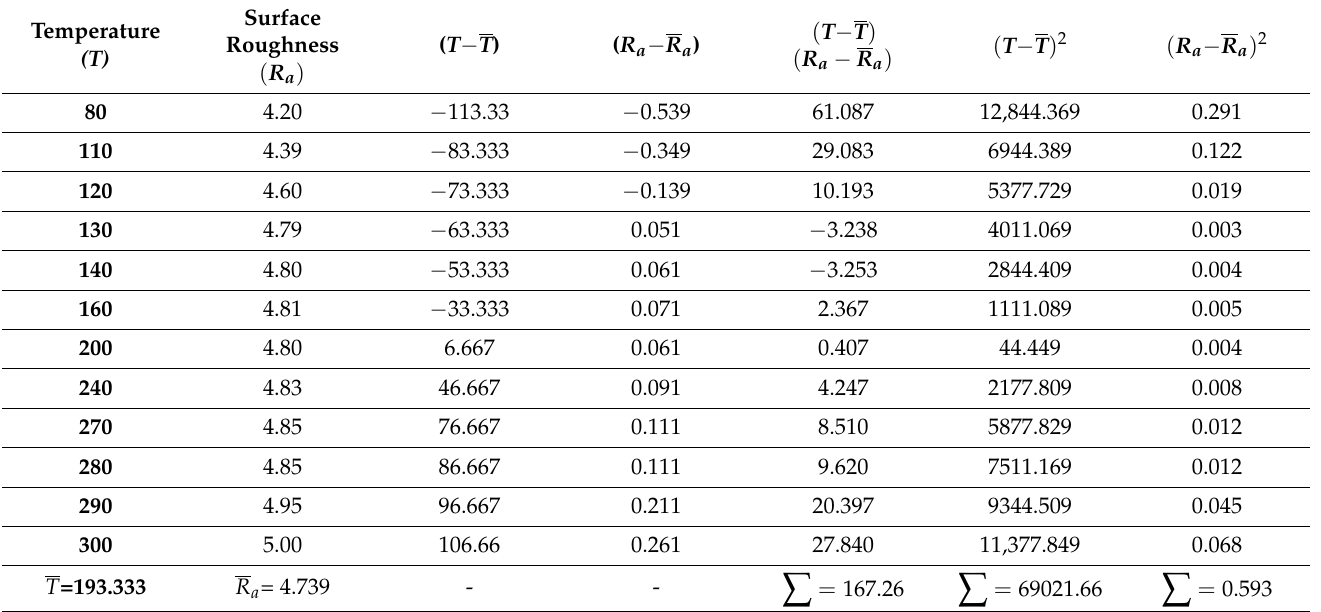
Table 3. Calculations needed to produce the predictability equation for the linear